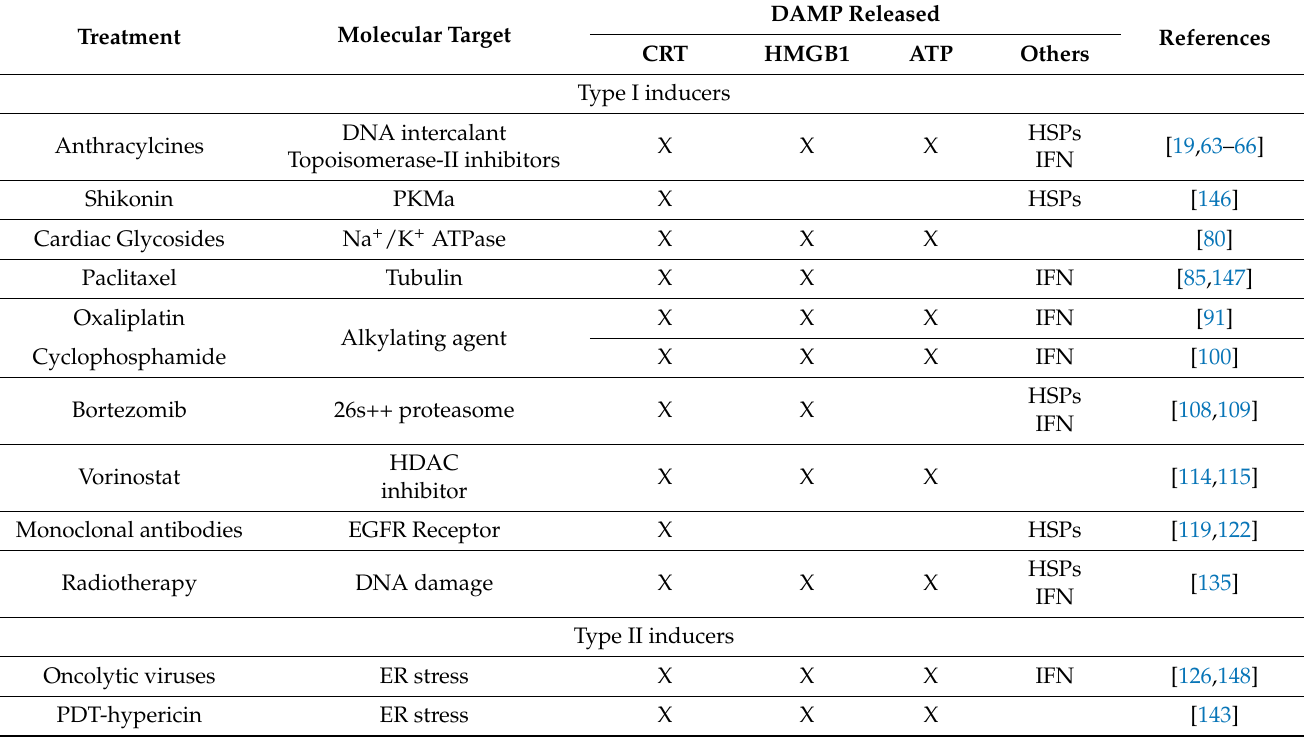
Table 1. Overview of major hallmarks of ICD inducers based on their molecular target and DAMP response-mediated.